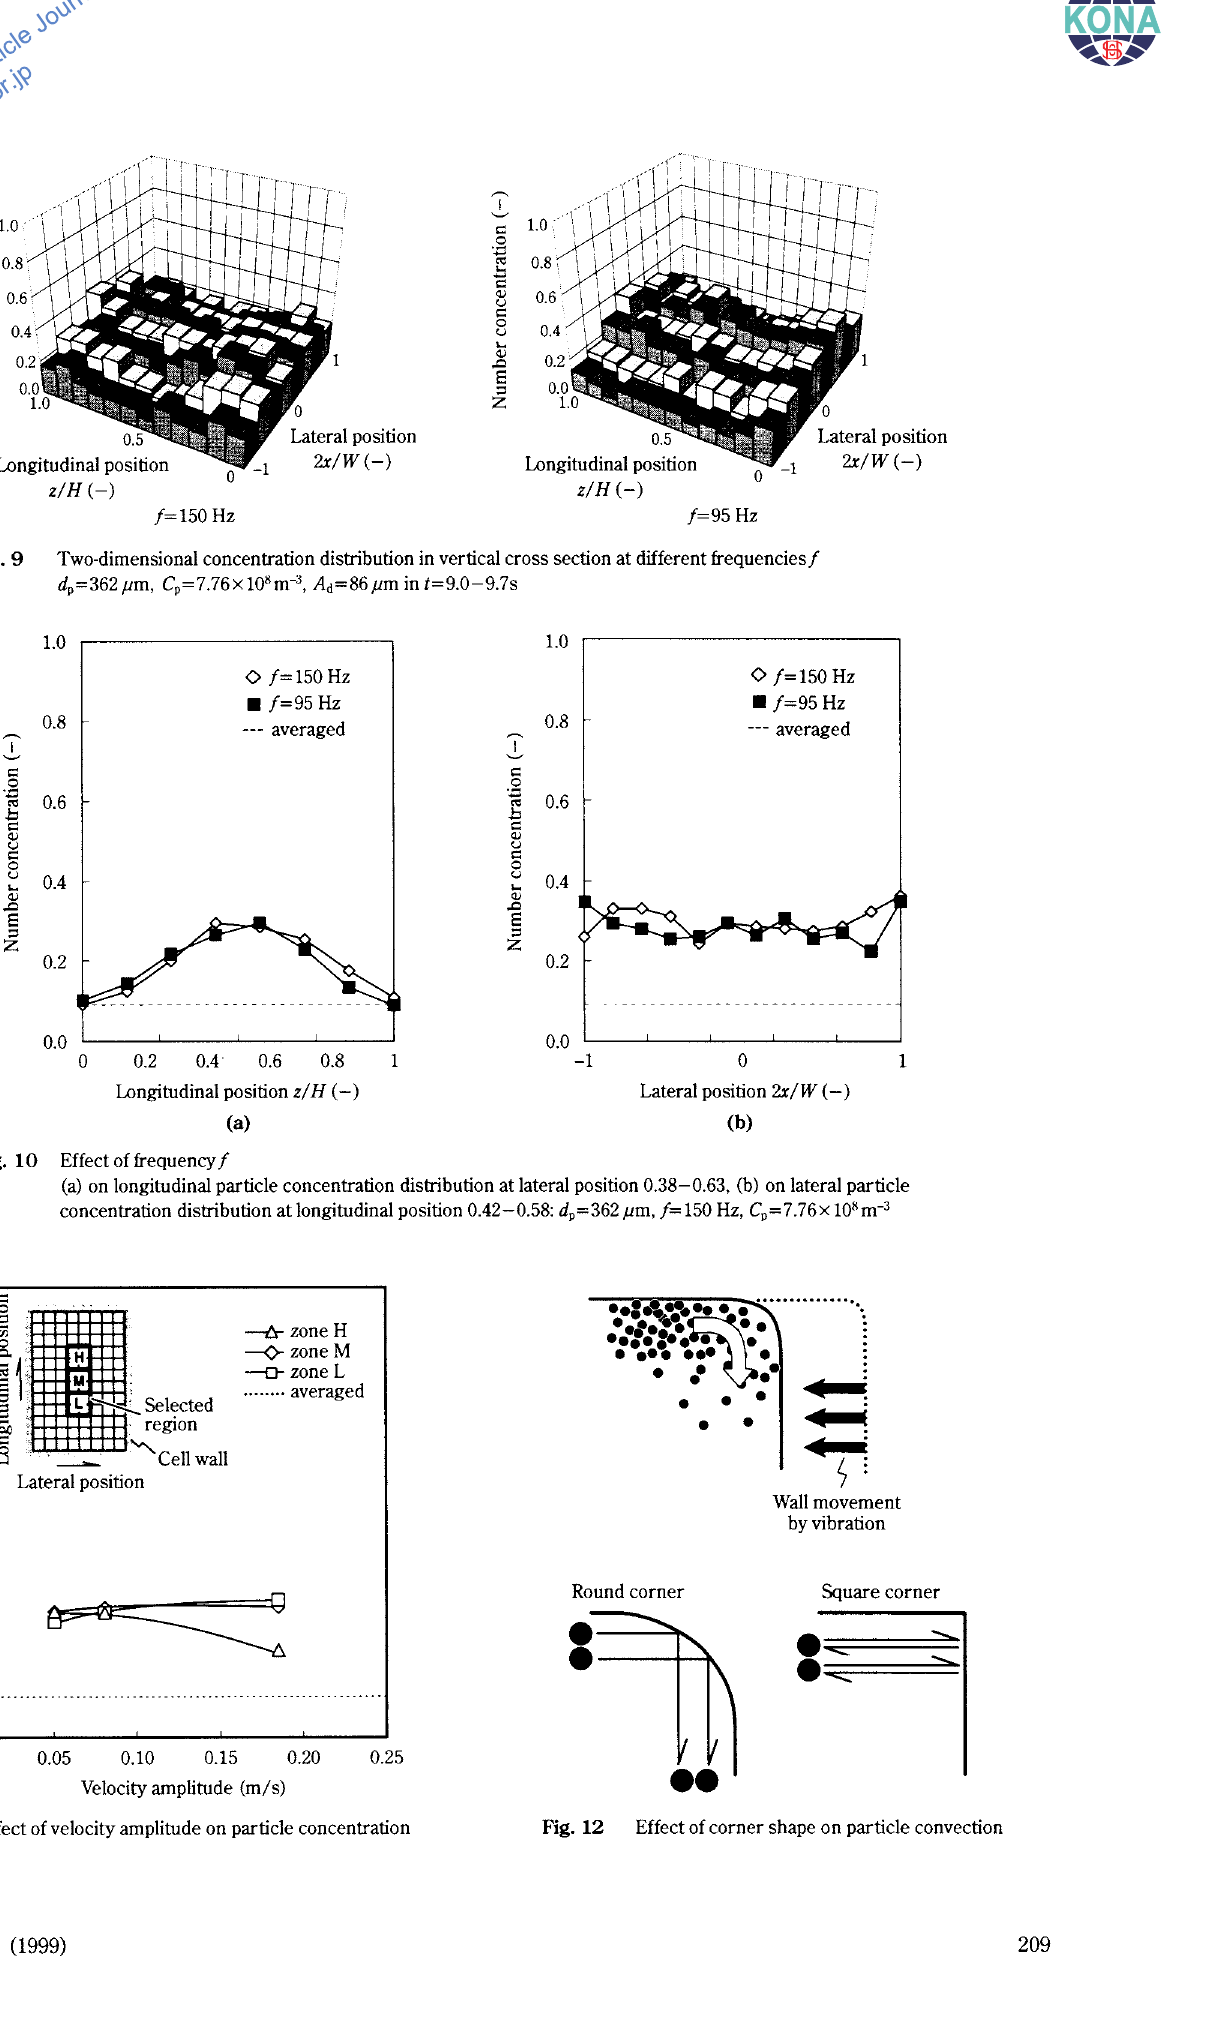
Fig. 11 Effect of velocity amplitude on particle concentration Fig. 12 Effect of corner shape on particle convection